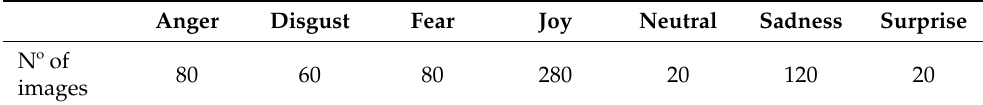
Table 2. Number of images per emotion of UIBVFED